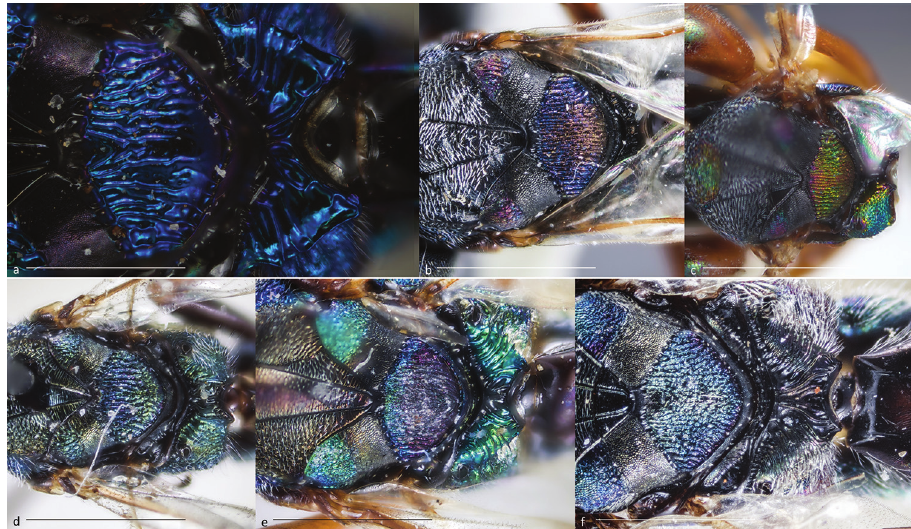
Figure 15. Mesoscutellum and propodeum (dorsal) II a O. gracilis Westwood (imaged specimen: OGr01) b O. heikewernerae sp. n. (OHe01, holotype) c O. hoggarensis Hedqvist (OHo02, paratype) d O. leibnizi sp. n. (OLe03, paratype) e O. longicollis (Cameron) (OLo01) f O. madegassa Bouček (OMad01, holo- type). Scale bars: 1